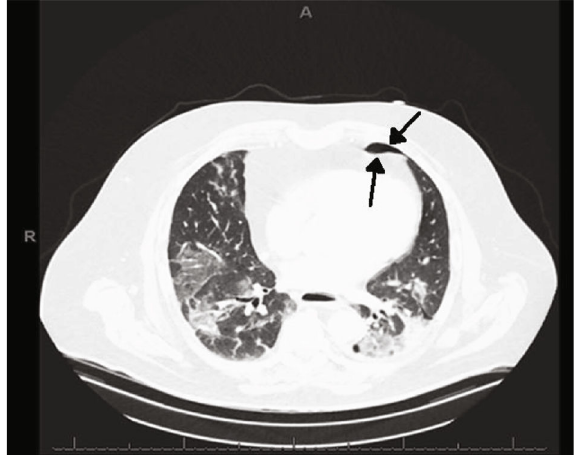
Figure 6: Axial CT chest shows bilateral basal predominant ground glass opacities, patchy left lower lobe consolidation, and left small pneumothorax (black